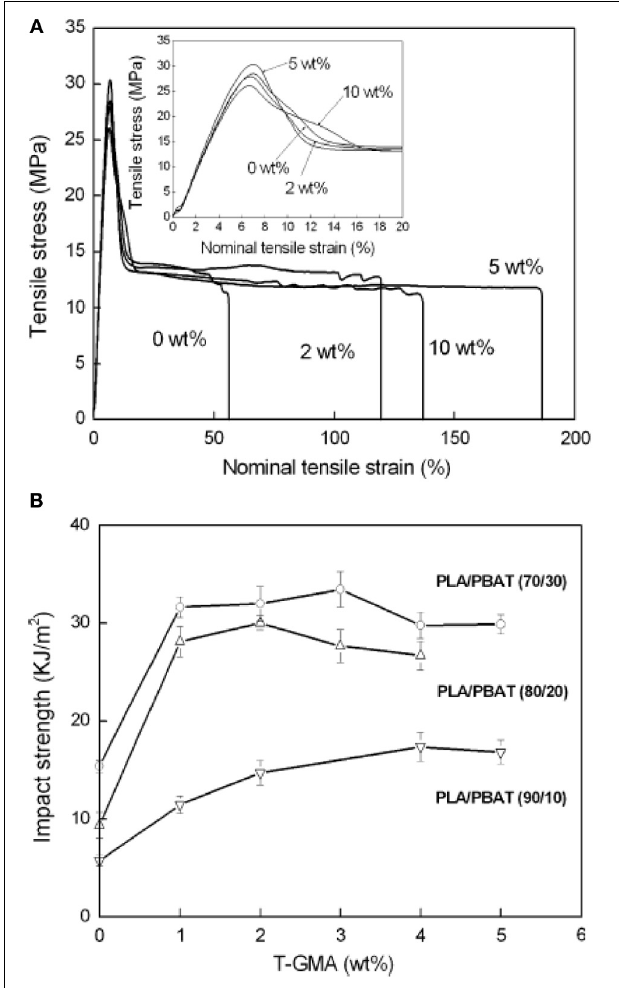
FIGURE 4 | (A) Stress–strain curves of PLA/PBAT (90/10wt%) blend in the presence of T-GMA. The inset gives details of stress–strain of the blends